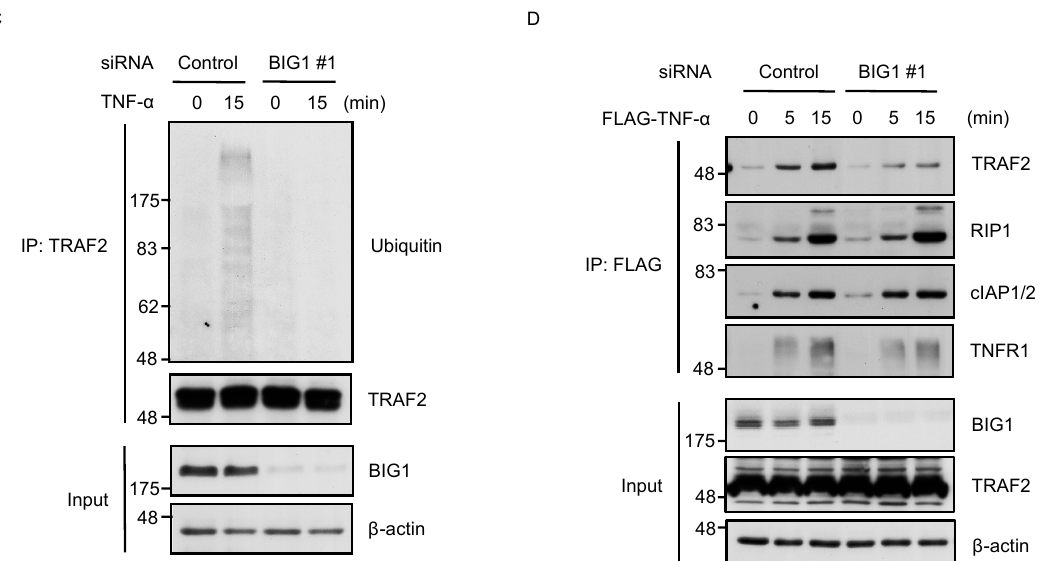
Figure 5. BIG1 is involved in the recruitment of TRAF2 to the TNF receptor 1 (TNFR1) signaling complex. ( A , B ) HT1080 cells were treated with 50 ng/mL TNF- α (A) or 2 μ g/mL DYKDDDDK (FLAG)-TNF- α (B) for the indicated periods. The cell extracts were immunoprecipitated with anti-TRAF2 ( A ) or anti-FLAG (M2) ( B ) antibody followed by immunoblotting with the indicated antibodies; ( C ) HT1080 cells were transfected with siRNA for negative control or BIG1. After 72 h, the cells were treated with 50 ng/mL TNF- α for the indicated periods. The cells were lysed in lysis buffer supplemented with 10 mM N-ethylmaleimide (NEM), and subjected to immunoprecipitation with anti-TRAF2 antibody (1st-IP). The heat-denatured immunoprecipitates with lysis buffer containing 1% sodium dodecyl sulfate (SDS) to disrupt noncovalent protein-protein interactions were diluted 10 times with lysis buffer, and immunoprecipitated with anti-TRAF2 antibody (2nd-IP) followed by immunoblotting with the indicated antibodies; ( D ) HT1080 cells were transfected with siRNA for negative control or BIG1. After 72 h, the cells were treated with 2 μ g/mL FLAG-TNF- α for the indicated periods. The cell extracts were immunoprecipitated with anti-FLAG (M2) antibody followed by immunoblotting with the indicated antibodies.